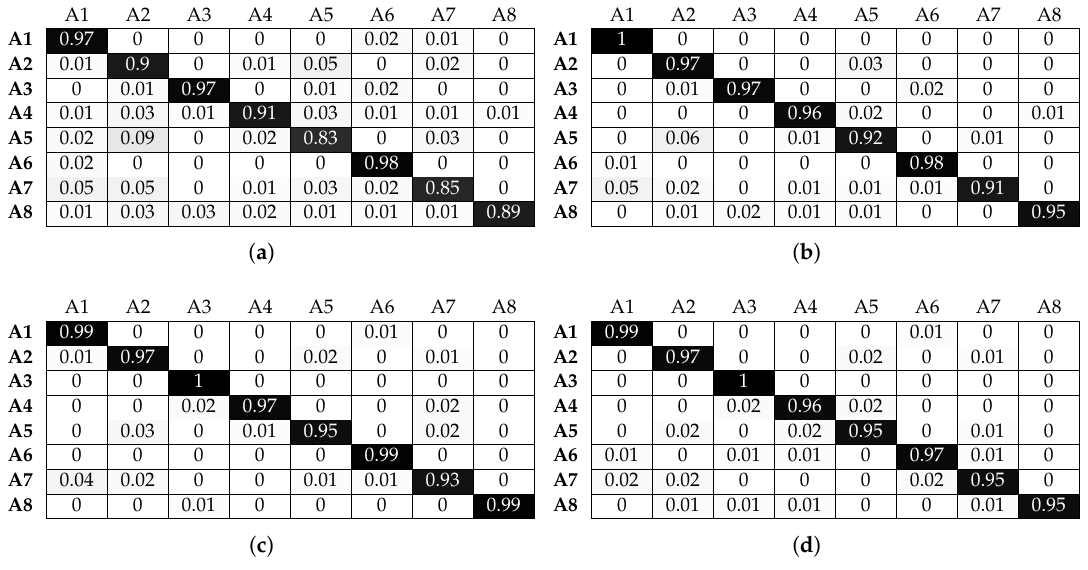
Figure 13. Normalised confusion matrices for KNN, with Wearable Feature Type 2, with beacon data. ( a ) n = 3, w = 1 s; ( b ) n = 3, w = 2 s ; ( c ) n = 3, w = 3 s; ( d ) n = 3, w = 4 s.